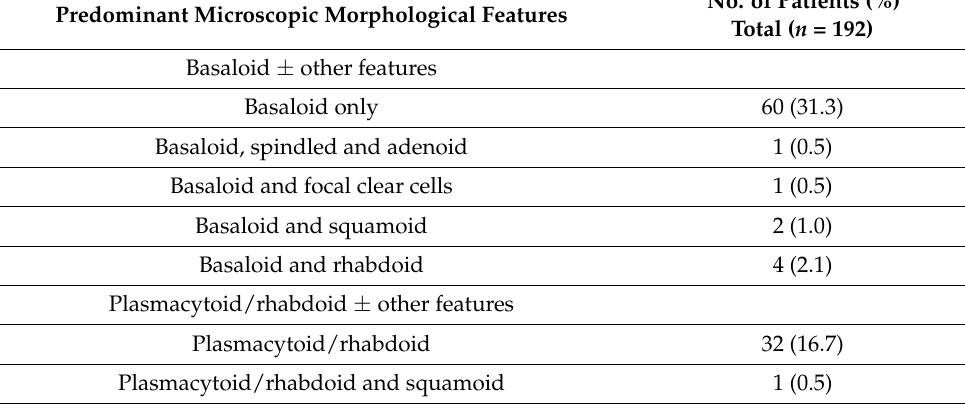
Table 2. Distribution of predominant microscopic morphological